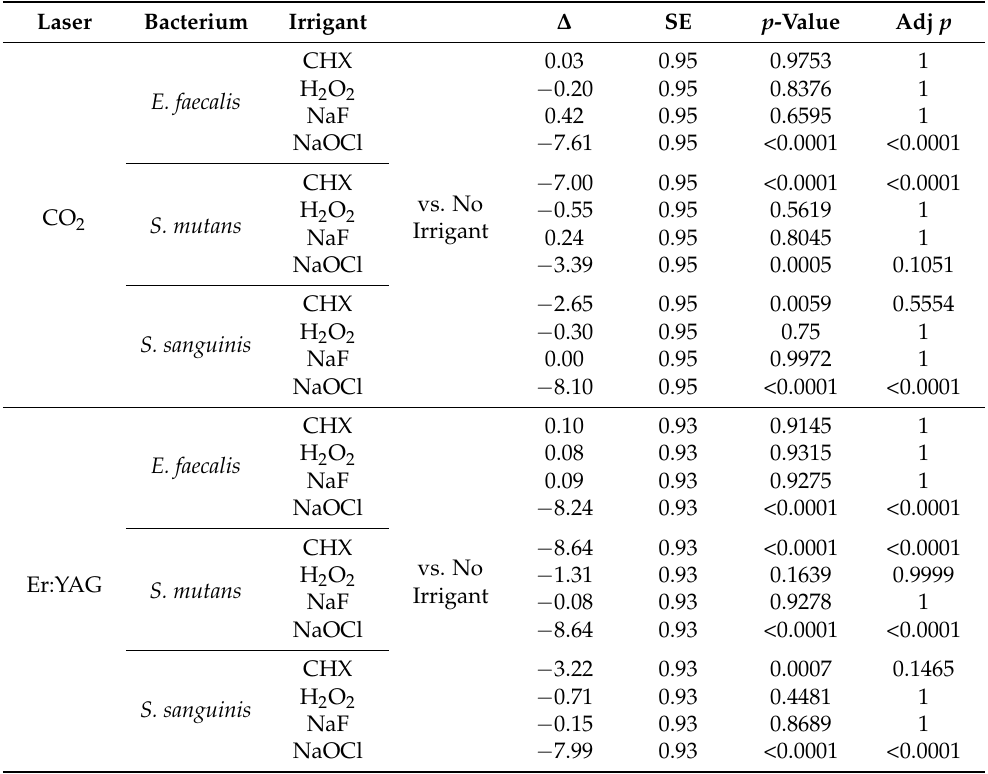
Table 3. Pairwise comparisons for effect of laser with and without an